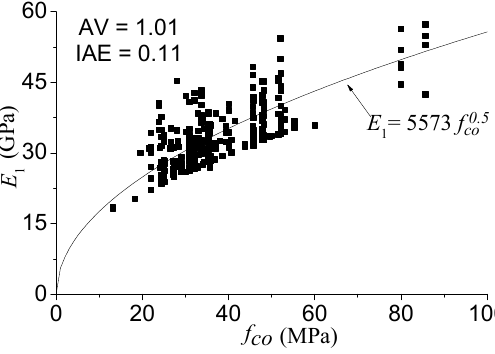
Figure 6. The performance of the E 1 model.